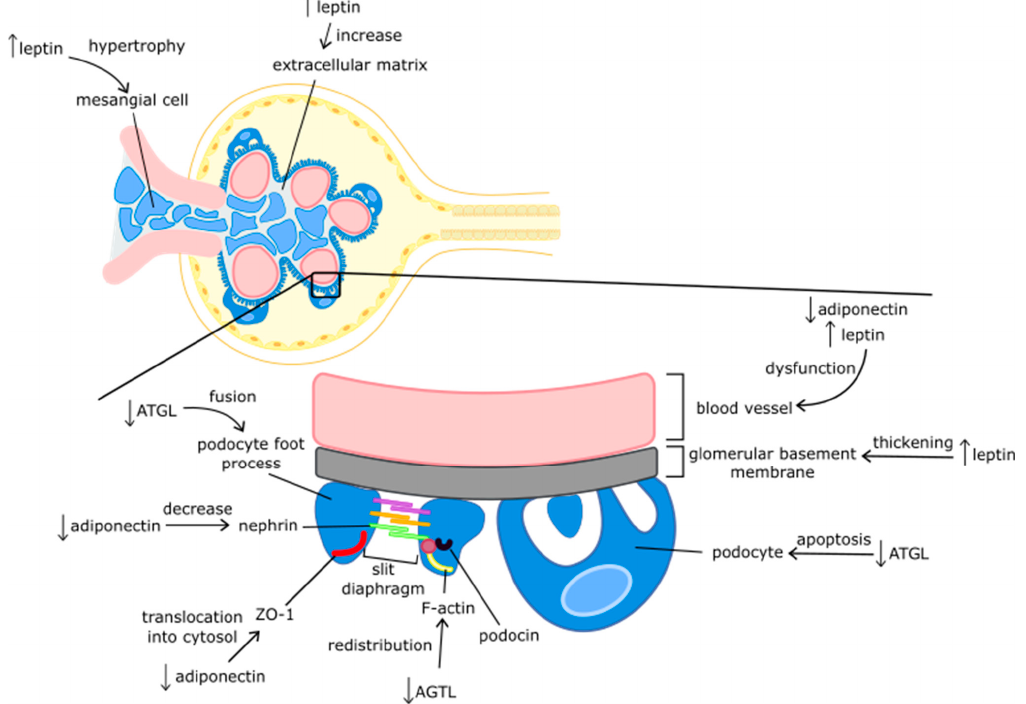
Figure 3. The influence of adipokines on the structures of the kidneys. Abbreviations: ATGL—adipose triglyceride lipase; ZO-1—zonula occludens; ↑ —increased levels; ↓ —decreased levels. triglyceride lipase; ZO-1—zonula occludens; ↑ —increased levels; ↓ —decreased